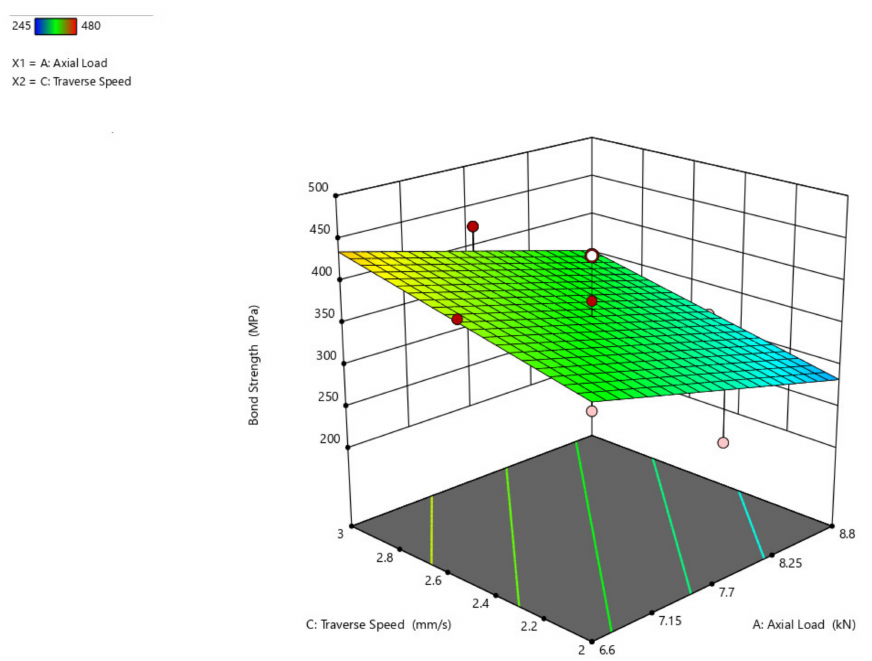
Figure 12. Interaction plot of axial load and traverse speed on bond strength (B s